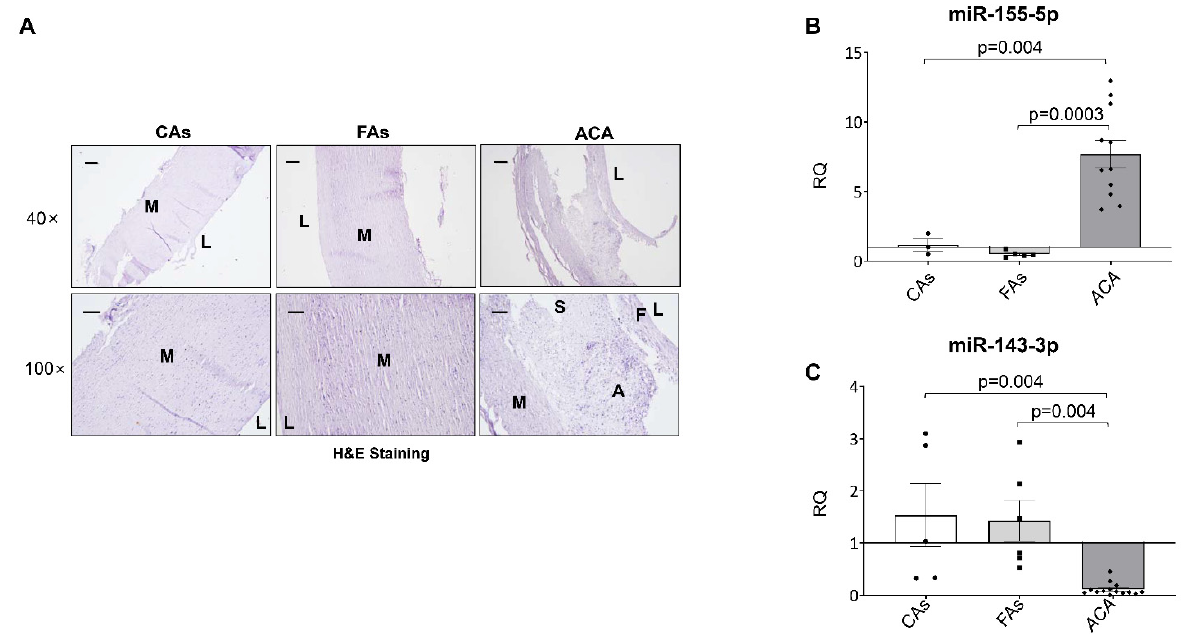
Figure 2. Characterization of the atherosclerotic plaques and miRNA expression of the human vas- cular samples. ( A ) Representative images of the Hematoxylin and Eosin staining from the aorta of control subjects (CAs) and subjects with fibrolipidic lesions (FAs) and the carotid artery from ACA patients (ACA). Magnification 40× (scale bar = 200 µm) and 100× (scale bar = 100 µm). Relative quan- tification of the levels of the miR-155-5p ( B ) and miR-143-3p ( C ) by qPCR. FAs= fibrolipidic plaque; ACA = advanced carotid atherosclerotic plaque; M = media; F = fibrous; S = shoulder; A = atheroma; L = lumen. qPCR miR-155-5p: Control subjects ( n = 3); FAs ( n = 5); ACA patients ( n = 11). qPCR miR- 143-3p: Control subjects ( n = 5); fibrolipidic patients ( n = 6); ACA patients ( n = 14).